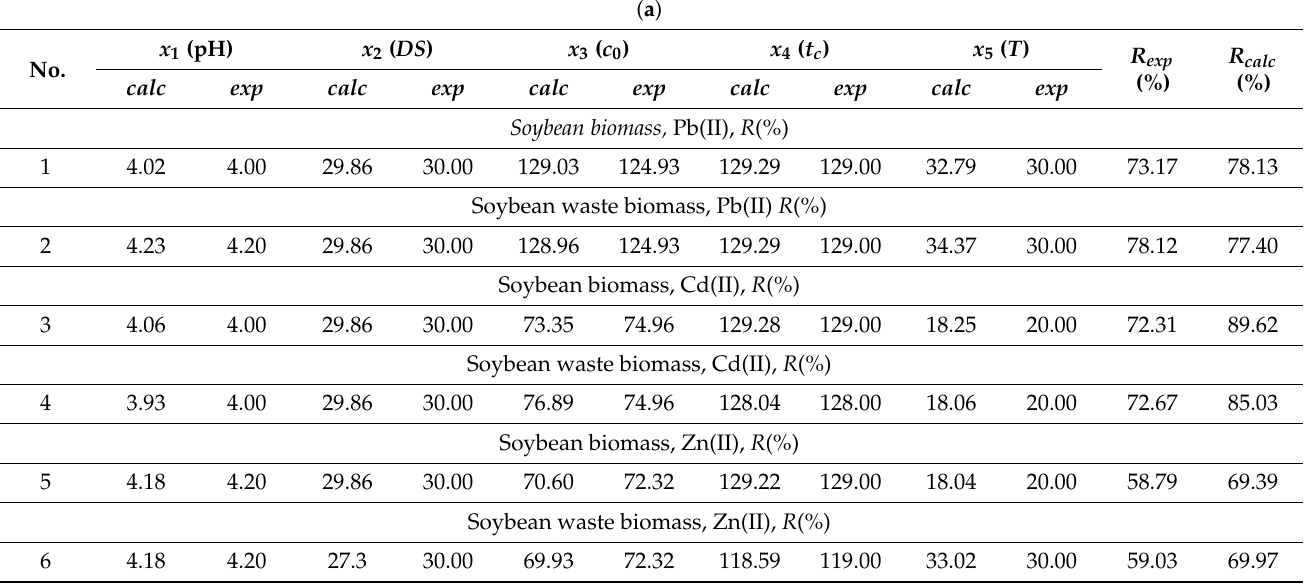
Table 14. ( a , b ) Experimental values of R (%) and q ( mg/g ) for validation of optimal solutions (Tables 10 and